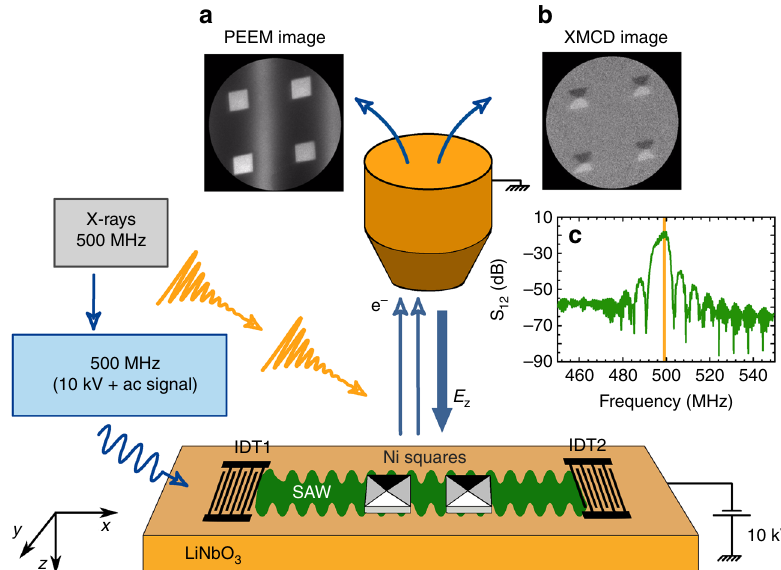
Fig. 1 Schematic plot of the experimental setup. Circularly polarized X-rays illuminate the sample in the form of 20 ps pulses with a repetition rate of f 0 ≈ 500 MHz. The interdigital transducer, IDT1, of the hybrid device receives an AC electric signal of the same frequency, which is phase locked to the synchrotron repetition rate, generating a piezoelectric surface acoustic wave ( SAW ) that propagates through the LiNbO 3 substrate and interacts with the magnetic nanostructures. The phase-resolved variation of the piezoelectric voltage at the surface sample is probed with the PEEM, as well as the magnetization contrast along the X-ray propagation direction arising from the XMCD effect. In a , a PEEM image with a fi eld of view of 20 × 20 μ m 2 shows four 2 × 2 μ m 2 Ni squares in presence of a piezoelectric wave front — black and white stripes indicate the sign of the piezoelectric voltage. In b an XMCD image of the same structures showing magnetic domains within the Ni squares. In c experimental rf-power spectrum of the transmission coef fi cient between IDT1 and IDT2, S 12 , tuned to have a maximum at f 0 . The resonance frequency f 0 is marked by a yellow